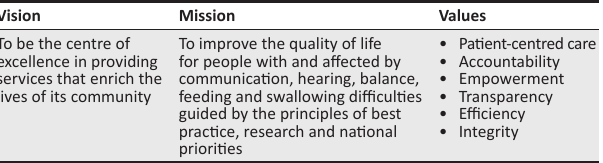
TABLE 2: Vision, mission and values of the Speech Therapy and Audiology Department.